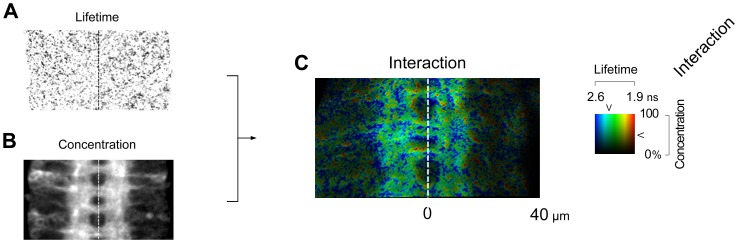
Spatial resolution of interaction.A. Lifetime is concentration-independent. B. Concentration varies from pixel to pixel and requires correction for FRET. C. Interaction is a product of lifetime and concentration.